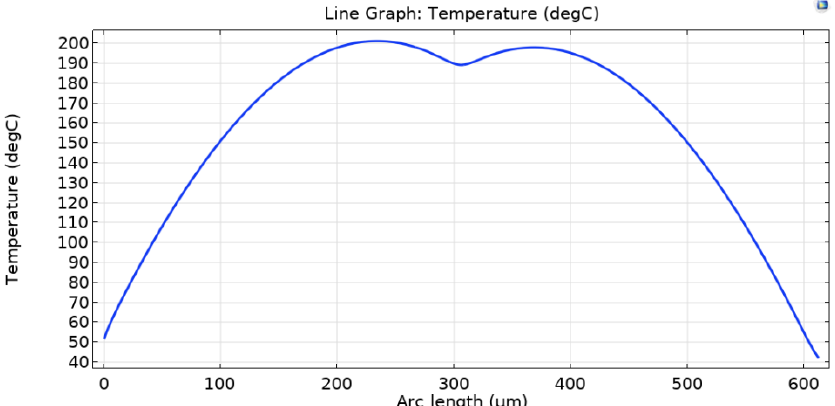
Figure 11. Temperature profile along the A-B-C path (Figure 10) of the Chevron arms at 150 mA input current.